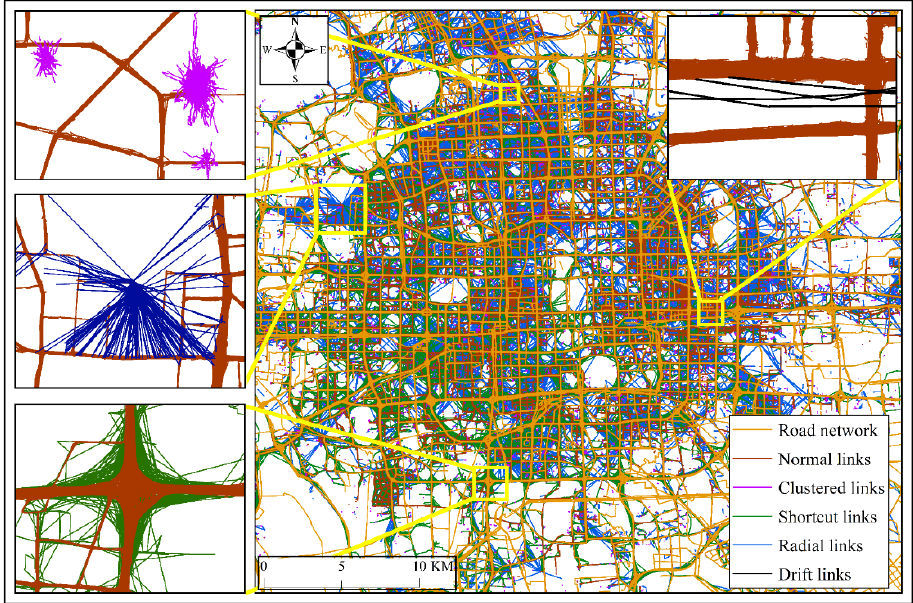
Figure 6. Plot of the labelled tracking links in